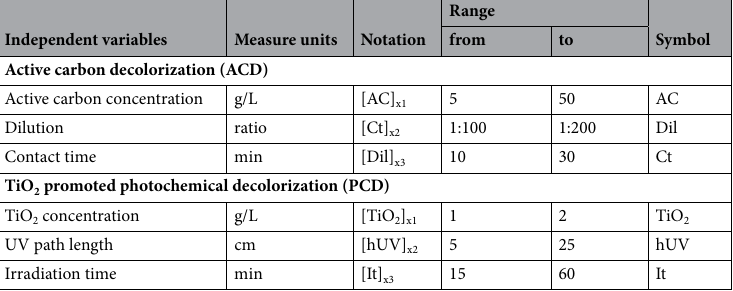
Table 1. Designated variables and their variation range for the chosen decolorization methods.